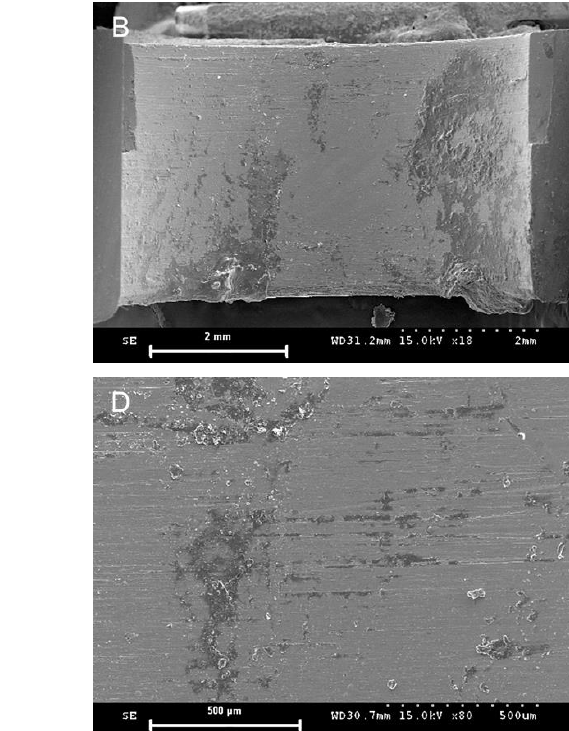
Figure 6. Representative scanning electron microscopic images. Cross-sectional view of a sleeve insert from a preoperative ( A ) and a postoperative ( B ) image from the MSF group in a lower magnification (18×). Cross-sectional view of a sleeve insert from a preoperative ( C ) and a postoperative ( D ) image from the MSF group at a higher magnification (80×).